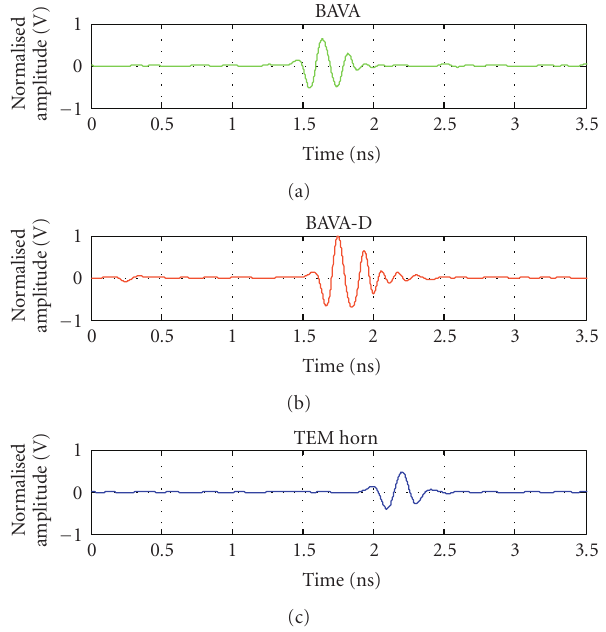
Figure 10: Normalized time-domain reflections from tumors recorded with each of the three antennas.